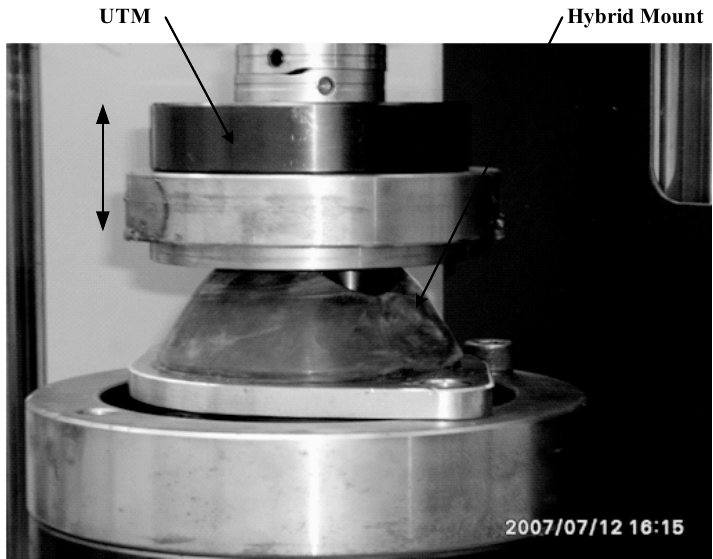
Fig. 11. Photograph of deflection test for the hybrid mount using